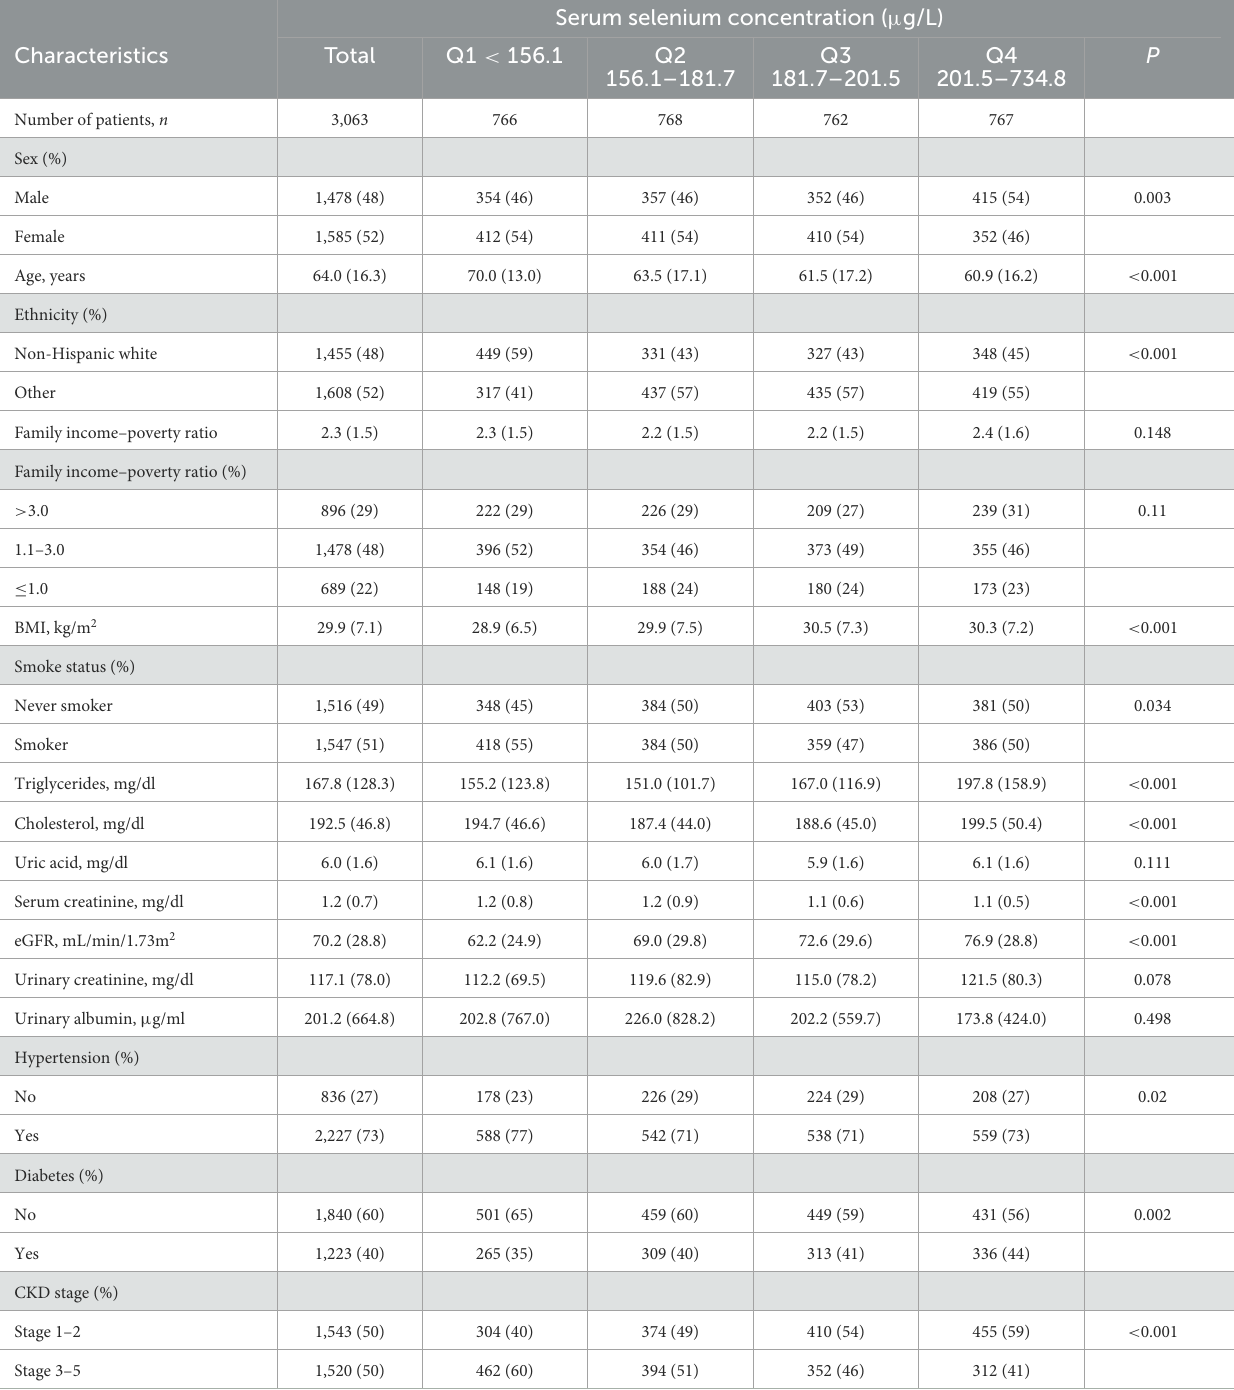
TABLE 1 Baseline characteristics of participants with CKD according to serum selenium in NHANES (1999–2000, 2003–2004, and 2011–2018) a